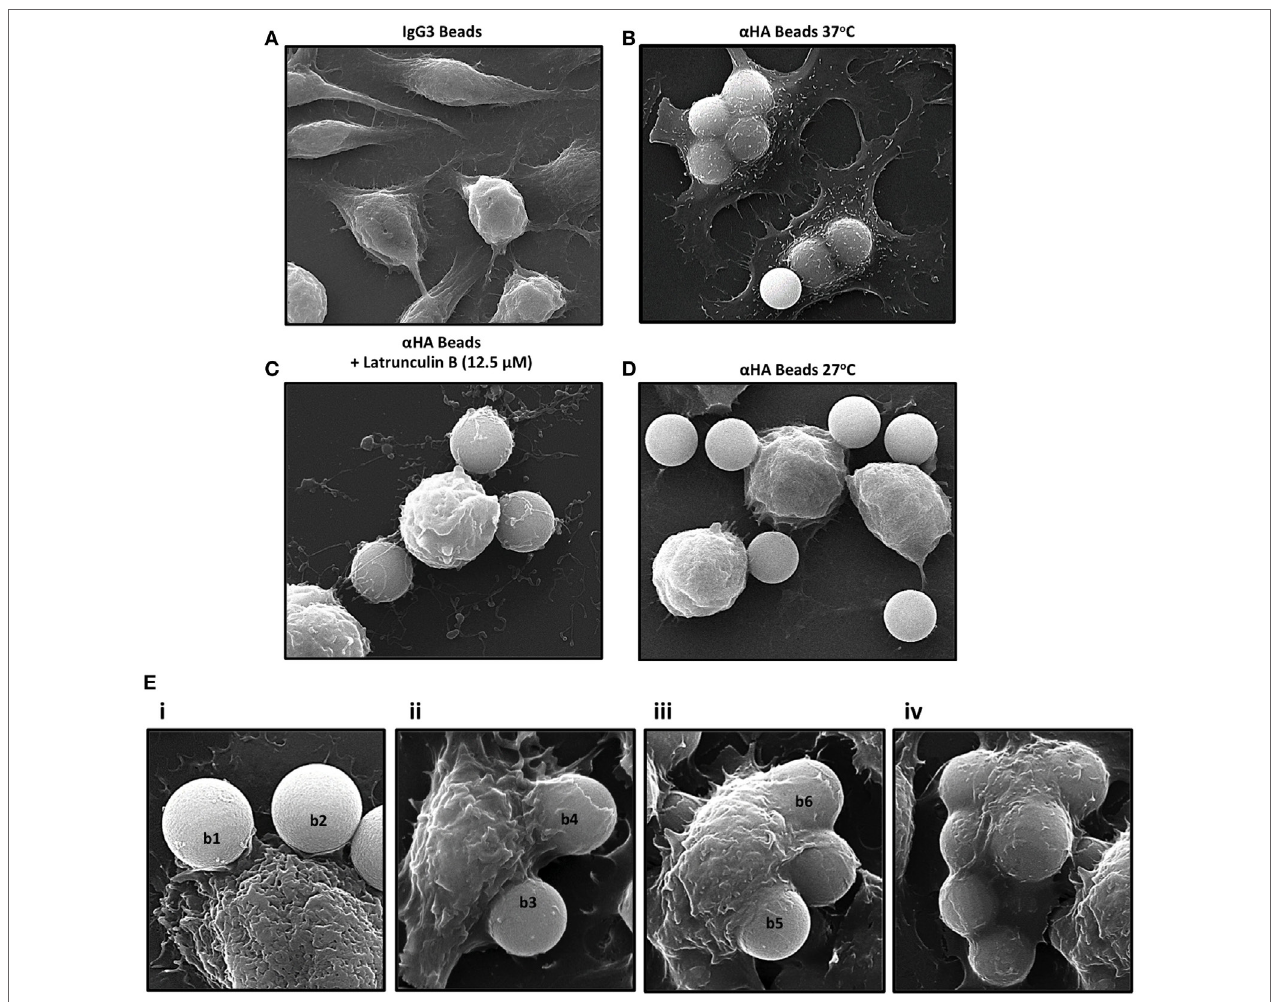
FigUre 1 | Scanning electron microscopy (SEM) of IpLITR 2.6b/IpFcR γ -L-mediated phagocytosis. IpLITR 2.6b/IpFcR γ -L-expressing rat basophilic leukemia-2H3 cells